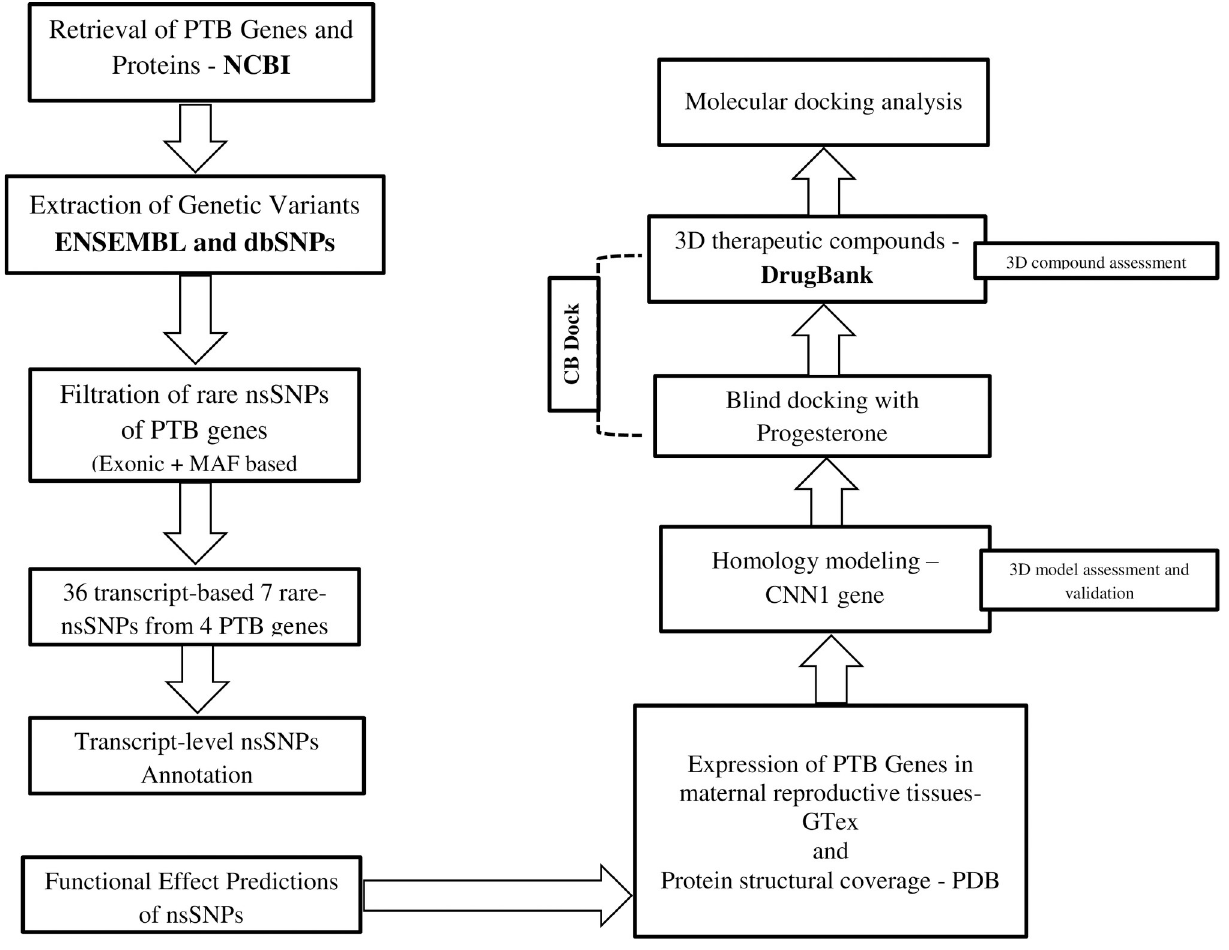
Fig 1. Schematic representation of